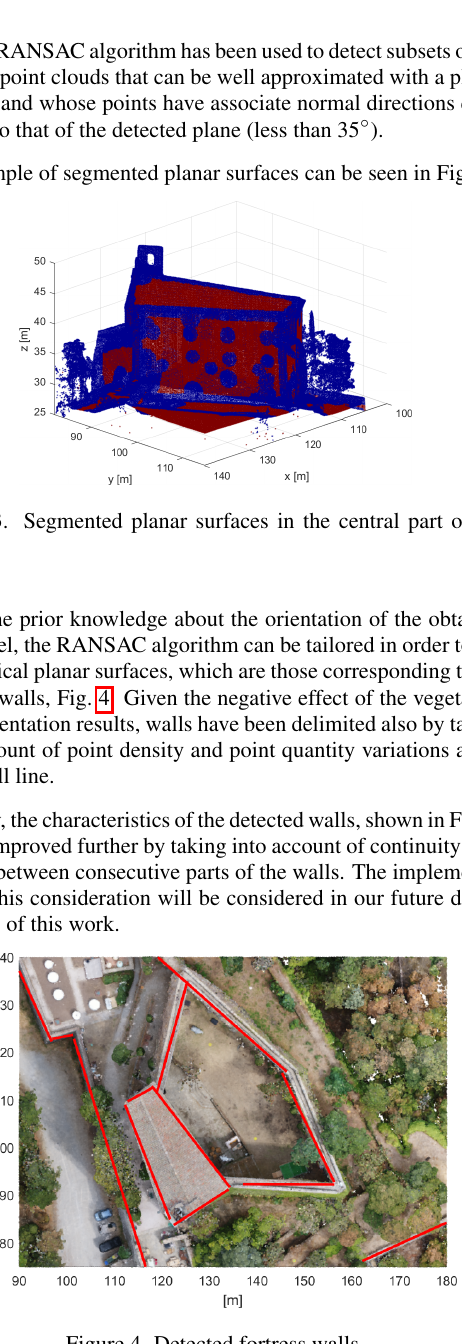
Figure 4. Detected fortress walls.